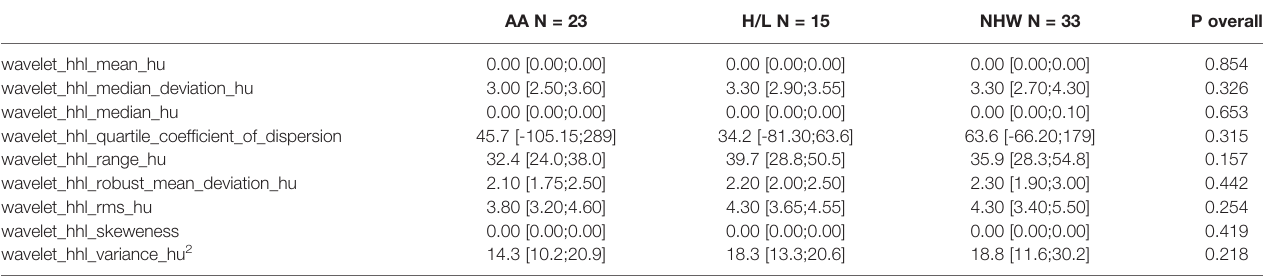
Frontiers in Oncology |